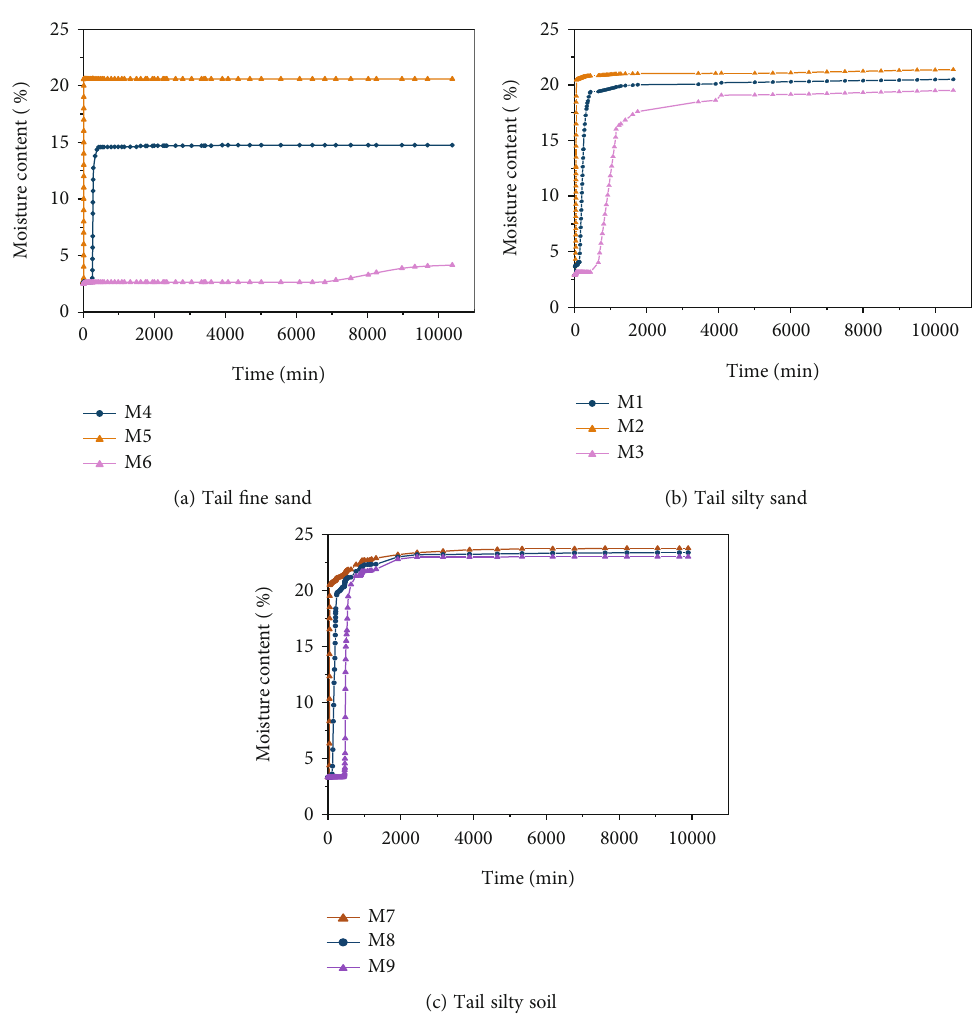
Figure 9: The relationship between moisture content and time at di ff erent sections.